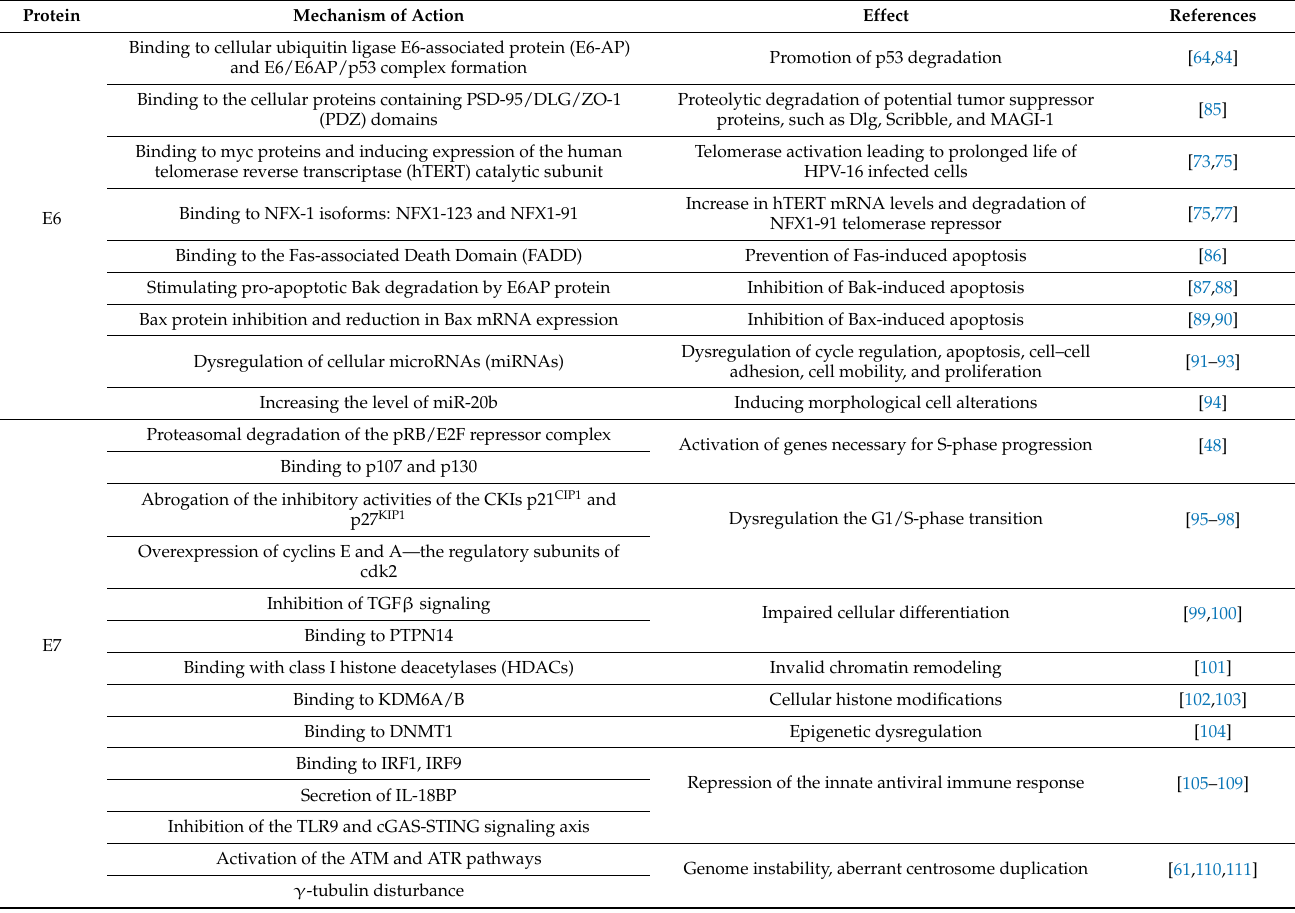
Table 1. Oncogenic proteins of HPV and their mechanisms of